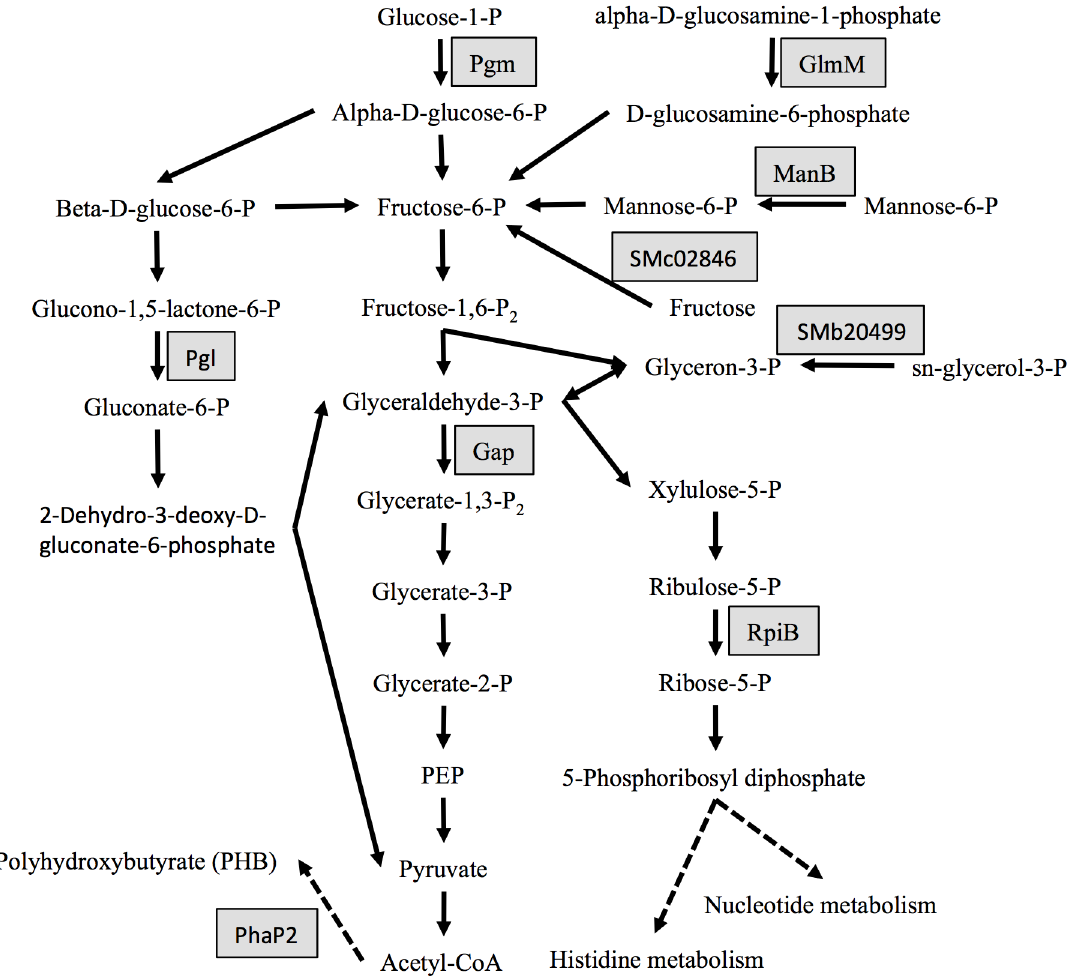
Fig 4. Phosphoproteins identified in carbohydrate metabolism. Gray box indicates phosphoproteins. PEP, phosphoenolpyruvate.